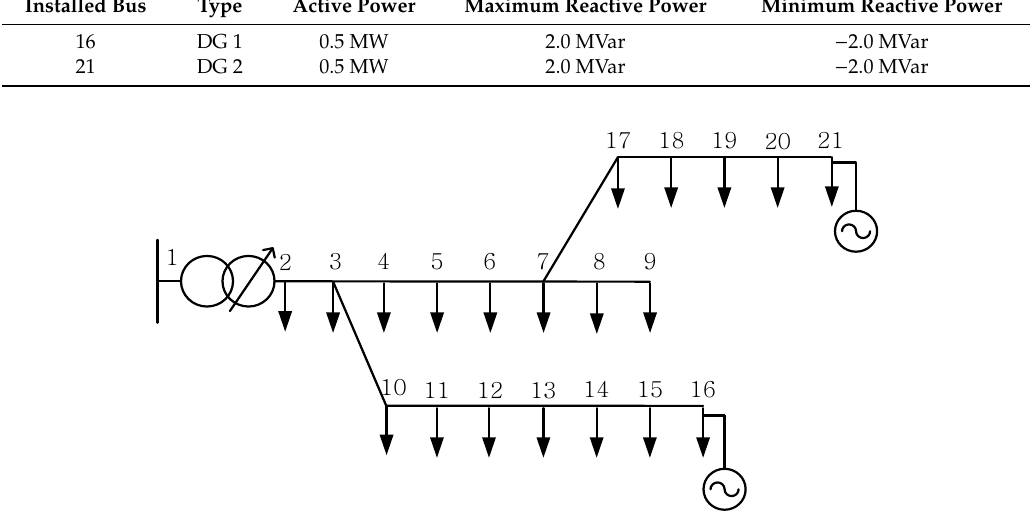
Table 5. Simulation results of the tap position and reactive power for nominal voltage in case 2. Control Component 2.0 MVar Figure 21. Comparison of optimal and proposed voltage profile for nominal voltage in case 2. Table 6 and Figure 22 show the voltage control results of voltage control for CVR. The tap position result of the OLTC is the same as the optimization result, and the reactive power of the DG shows different results. However, the voltage profile shows almost identical results. Table 6. Simulation results of the tap position and reactive power for CVR in case 2. Control Component